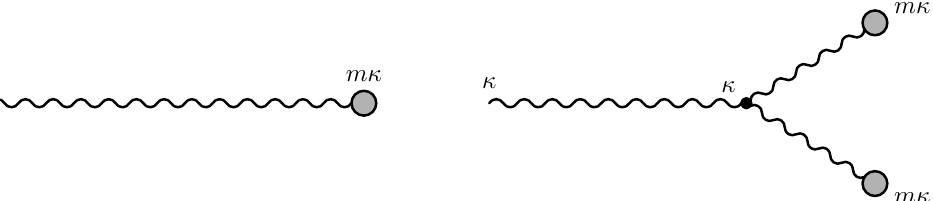
. They agree with N